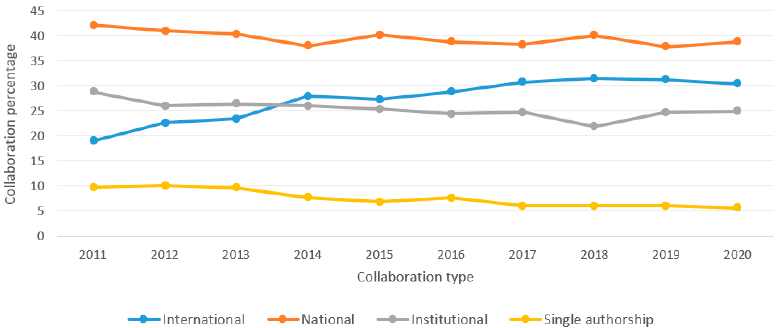
Figure 7. Documents on the topic of “healthy aging” with respect to the type of collaboration according to Scopus (2011–2020).